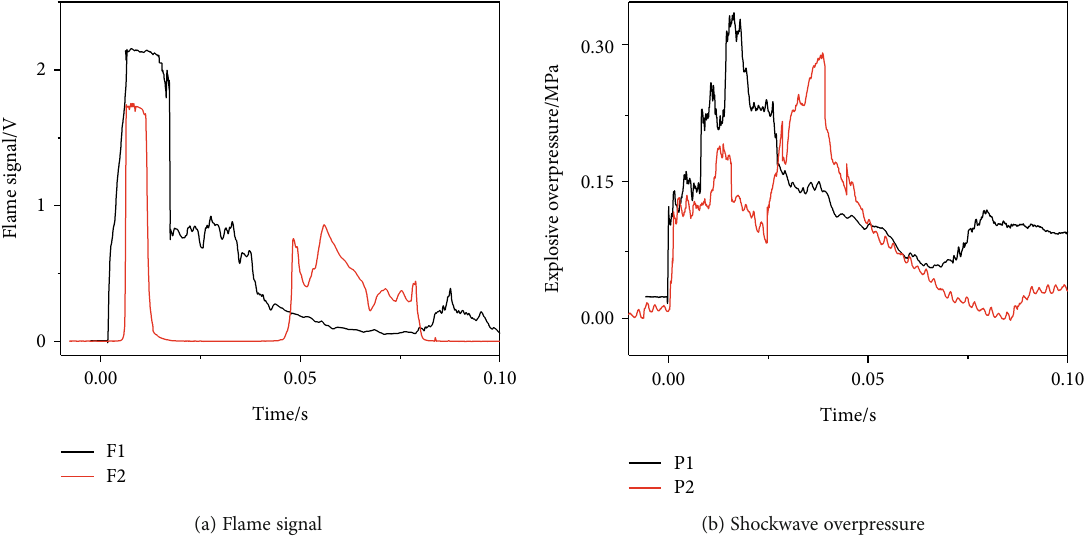
Figure 4: Explosion fl ame and shock wave